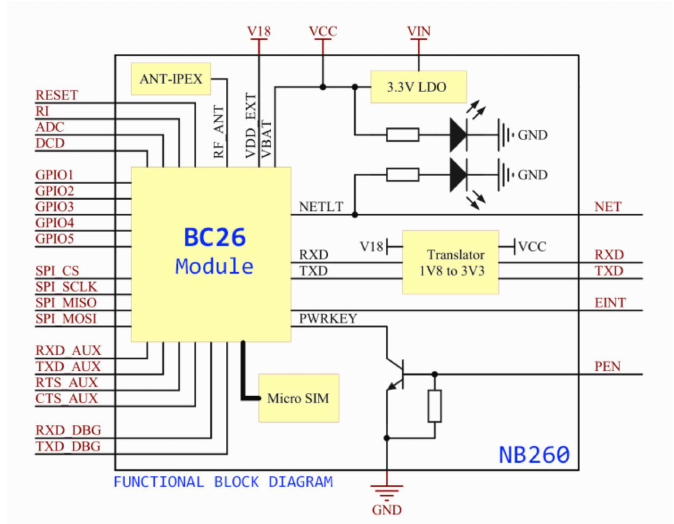
Figure 4. NB260 functional block diagram.